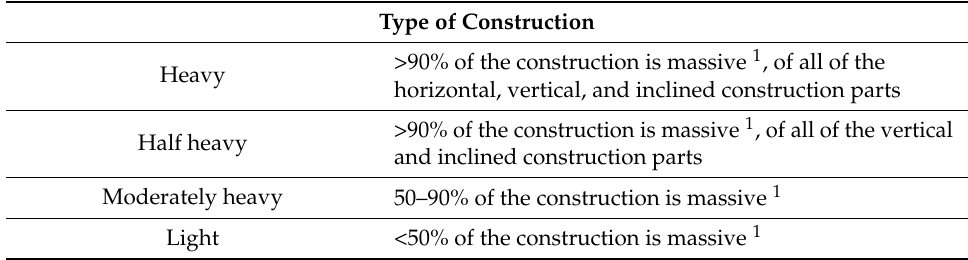
Table 1. The type of construction.